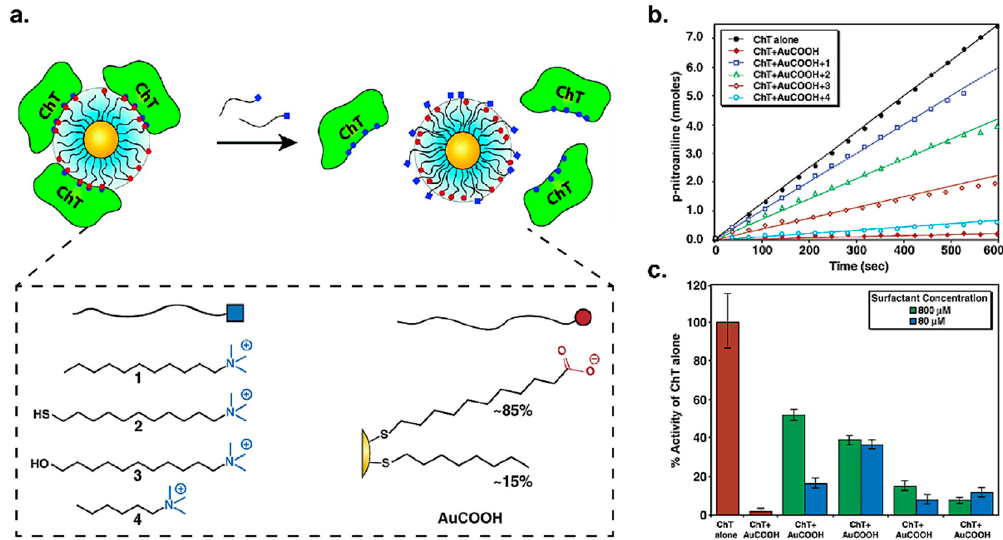
Figure 1. ( a ) Schematic illustration of the mechanism of rescuing chymotrypsin activity using long-chain surfactants. ( b ) Initial velocities of chymotrypsin before and after adding four different surfactants. Chymotrypsin reactivation was monitored via the hydrolysis of the chromogenic substrate N -succinyl- L -phenylalanine p-nitroanilide (SPNA), as measured by UV–vis spectroscopy. ( c ) Reactivation of chymotrypsin is dependent on surfactant concentration. (Adapted with permission from Reference [28]; Published by American Chemical Society, 2003).